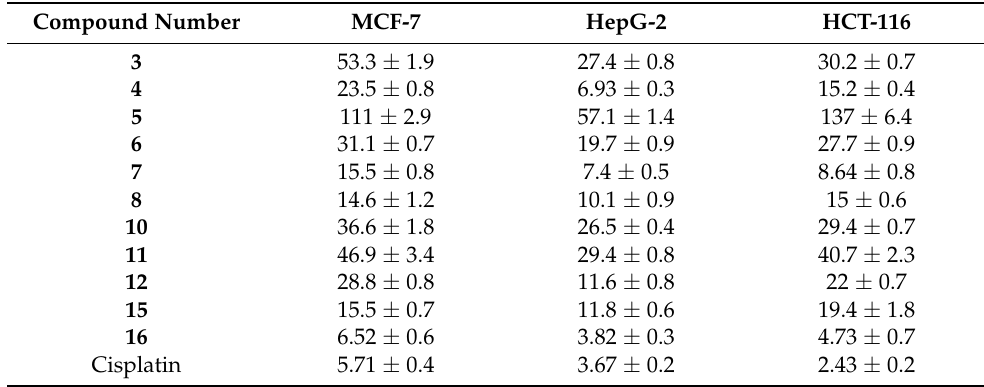
Table 1. The antitumor activities of the tested compounds expressed as IC 50 values and compared with reference standard drugs evaluated on breast, liver cancer and colon carcinoma cell